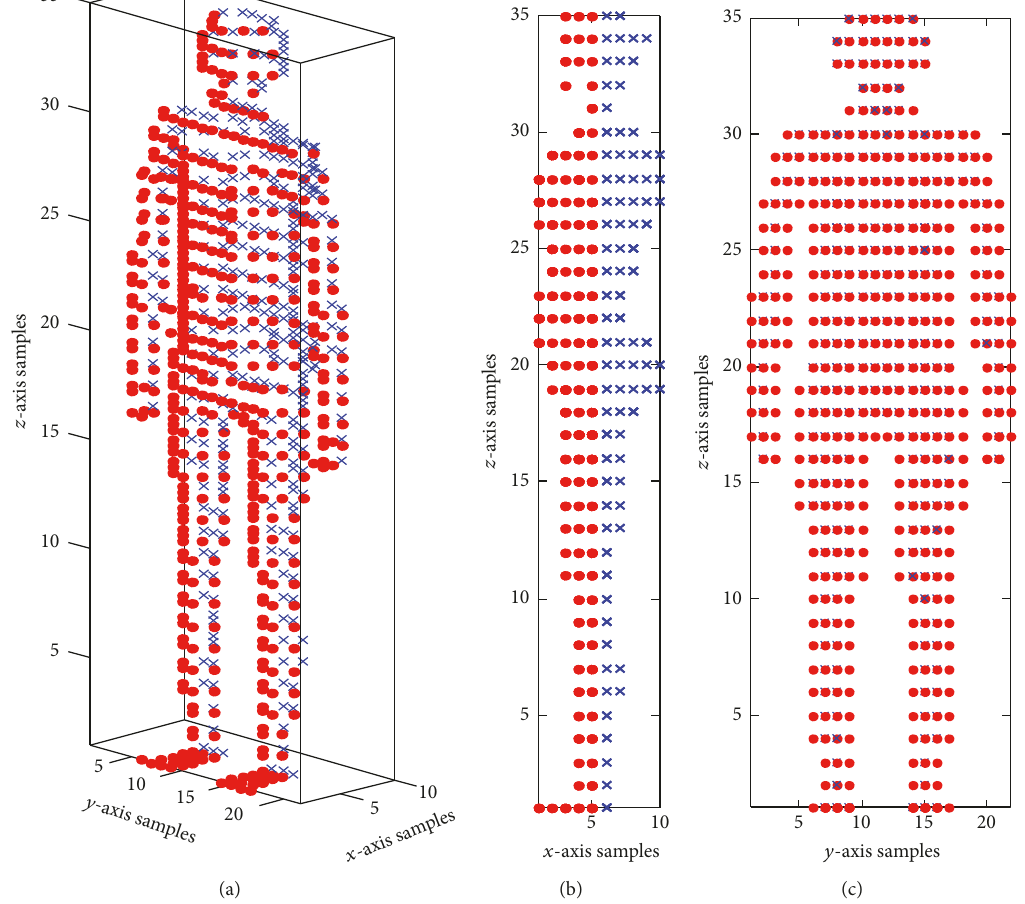
Figure 3: Numerically generated human body model with an ensemble of 816 point scatterers, where 486 of the scatterers from the front of the body (red points) are utilized to generate the simulated radar echoes, whereas the left ones (blue crosses) represent the body part that cannot be penetrated by microwave: (a) 3D view; (b) side view; (c) front